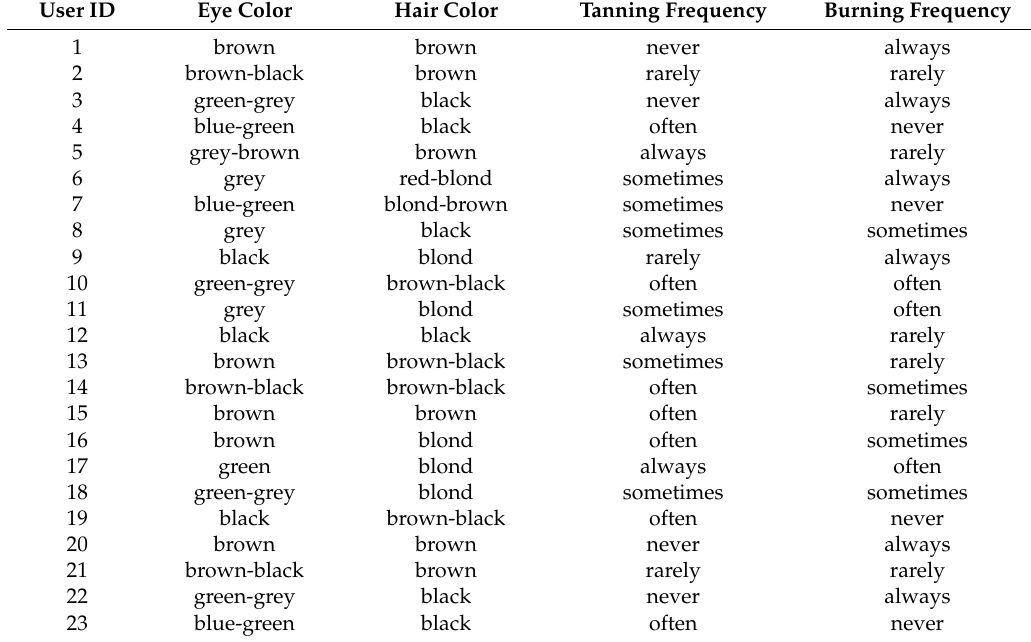
Table 4. The user profiles regarding eye and hair color, as well as tanning and burning